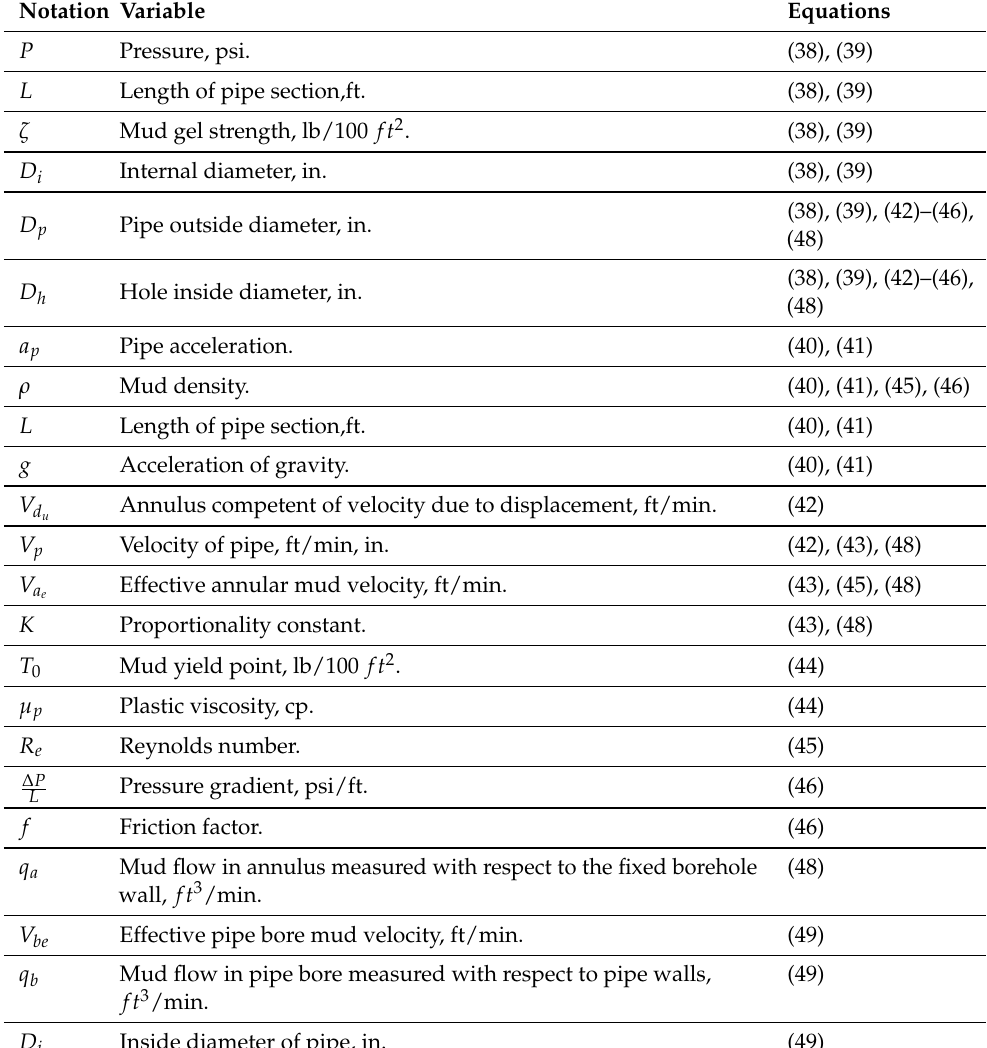
Table 3. The variables used in the model by Brukhardt